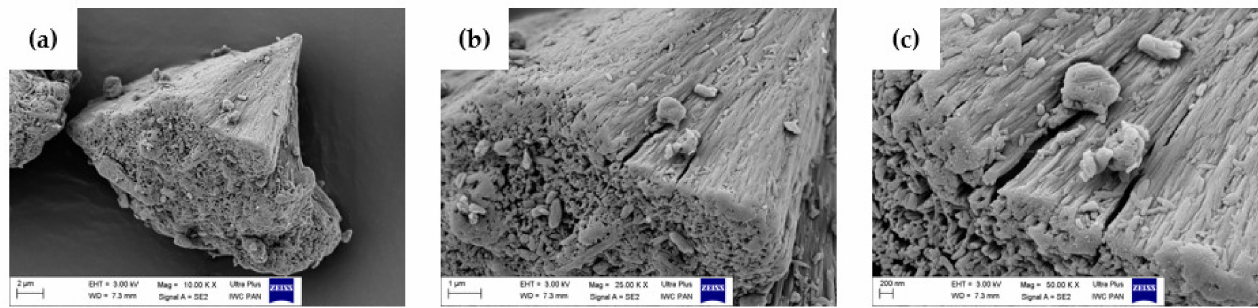
Figure 8. Morphology of hesperidin powder obtained by the scanning electron microscopy (SEM) with ( a ) 10,000 × , ( b ) 25,000 × , ( c ) 50,000 × magnification,